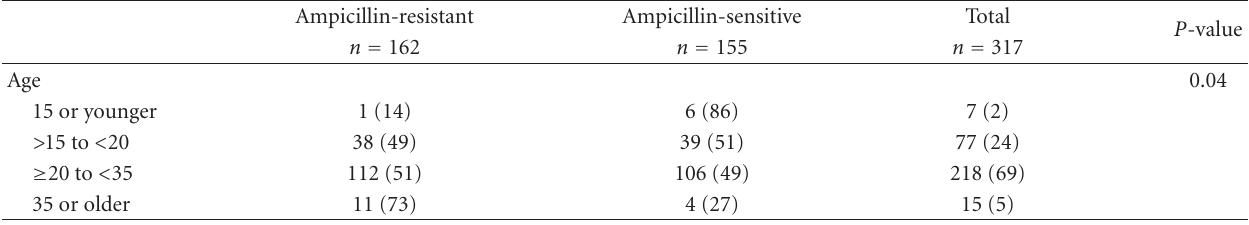
Table 3: Comparison of ages of women with ampicillin-resistant versus ampicillin-sensitive uropathogens in acute antepartum pyelonephritis . Data are reported as n (%).